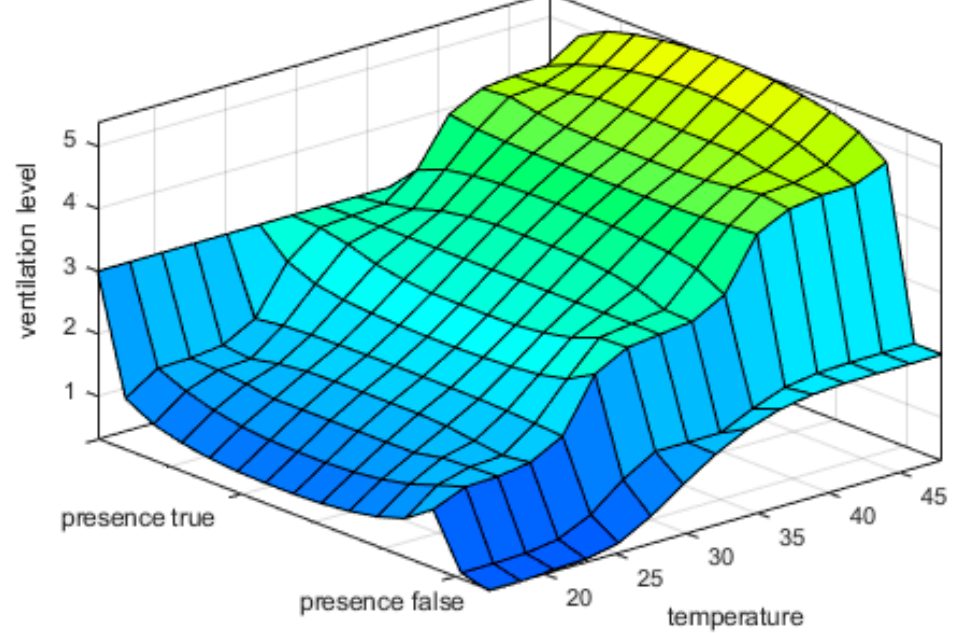
Figure 7. Ventilation level dependency on temperature and presence.